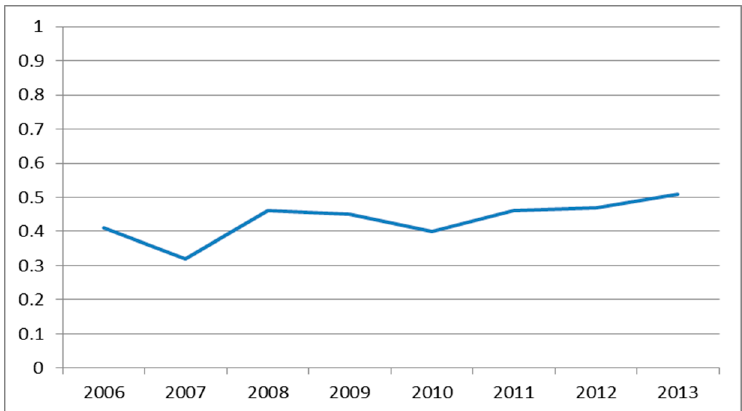
Figure 3. Average efficiency of banks in CEE countries in the time period 2006–2013 using output net interest margin. Source: processing using data from BankScope.